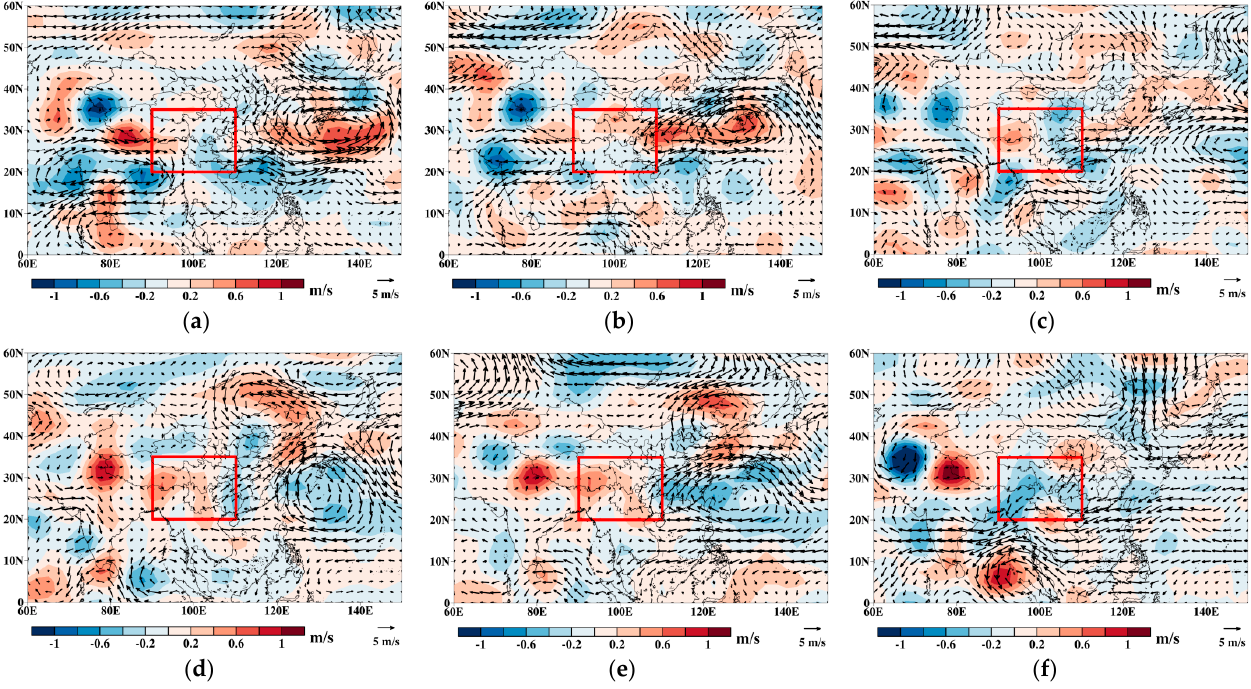
Figure 22. Homochronous 850 hPa wind field and 700 hpa vertical speed field in the second cycle of 30–60 days ISO in 1998. (Unit: m·s − 1 ; ( a – f ) means phases 1–6; area in red box is southwest China.).